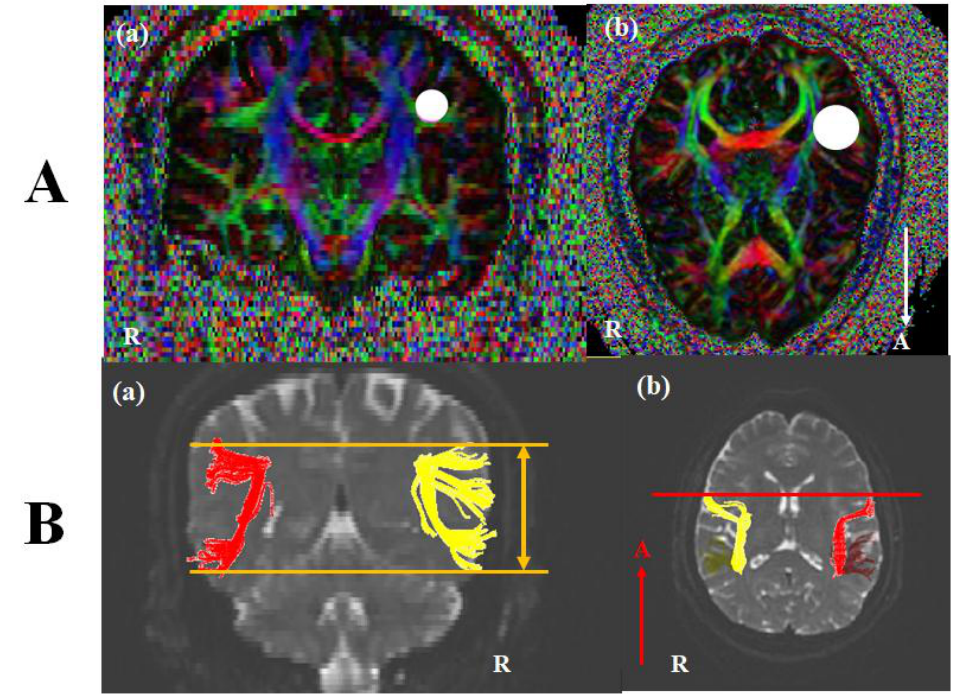
Figure 1. ( A ) Seed and target region of interest (ROI) of the AF. For the AF, ( a ) A seed ROI was placed in the lateral to the corona radiate and medial to the cortex on coronal slices (white circle), and ( b ) a target ROI was selected in superior temporal gyrus on axial slices (white circle). ( B ) Di ff usion tensor image (DTI) of the AF. ( a ) Based on Broca’s territory or Wernicke’s territory of the right AF on the coronal slice, we investigated the up or down movement of the left AF (orange line). ( b ) Inn the axial view, the shift of the left AF was observed compared with Broca’s area of the right AF (red line). Note: AF, arcuate fasciculus; R, right; A, anterior. Table 2. Diffusion tensor image (DTI) parameter values of the arcuate fasciculus of patients and control subjects ( n = 15). Left AF Right AF